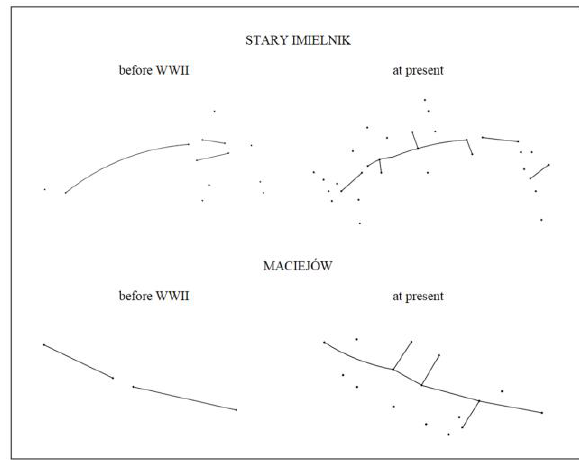
Fig. 5. Graphs depicting the low rank of morphological changes of the villages Stary Imielnik and Maciejów (in the extra-urban area) (Source: own